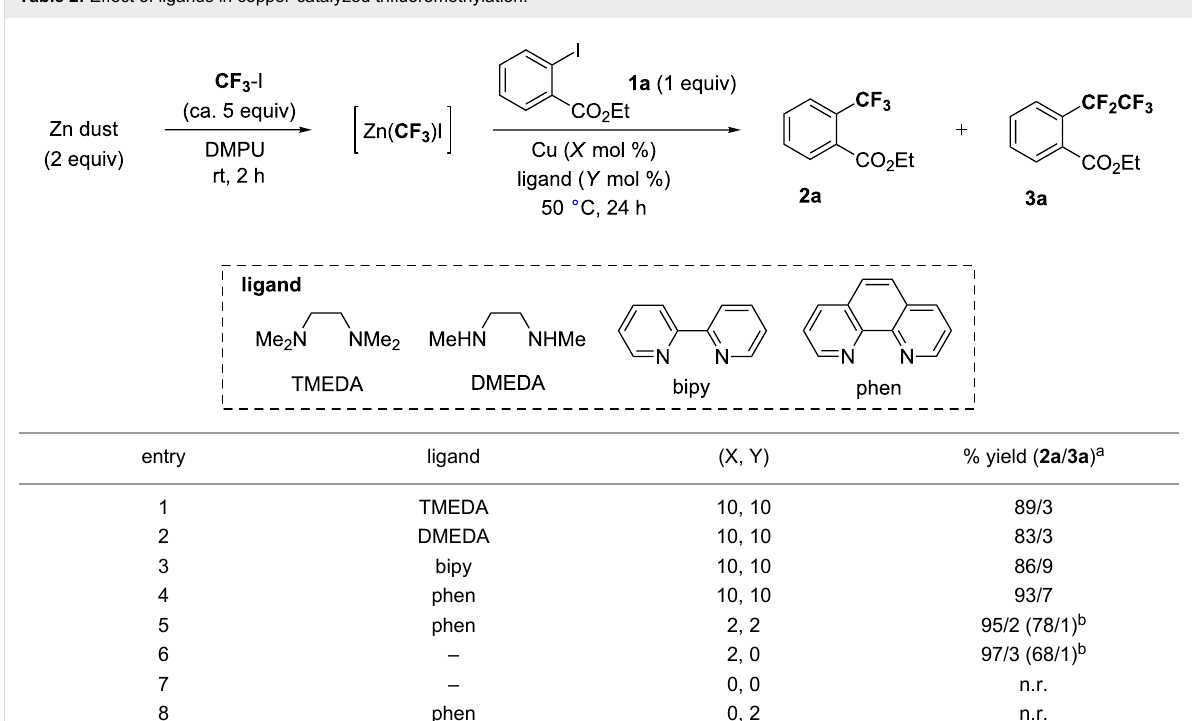
Table 2: Effect of ligands in copper-catalyzed